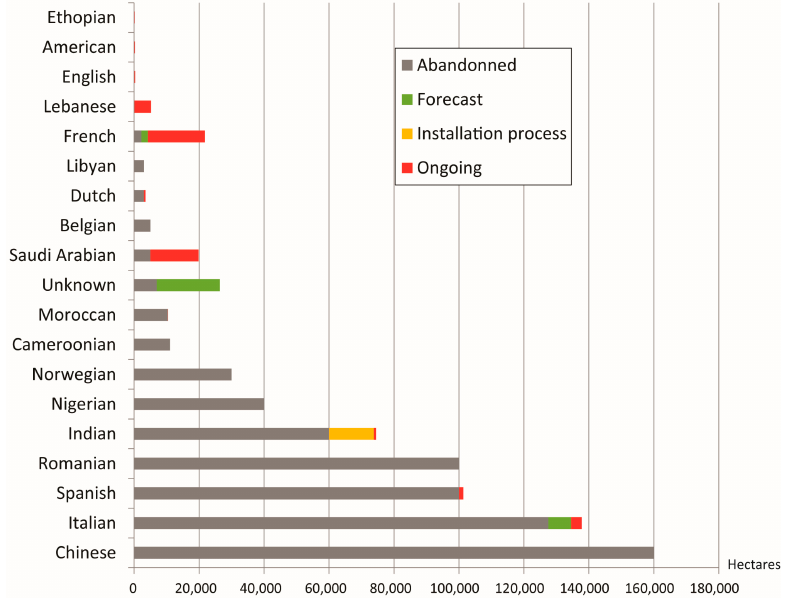
Figure 6. Nationality of agribusiness and status of land